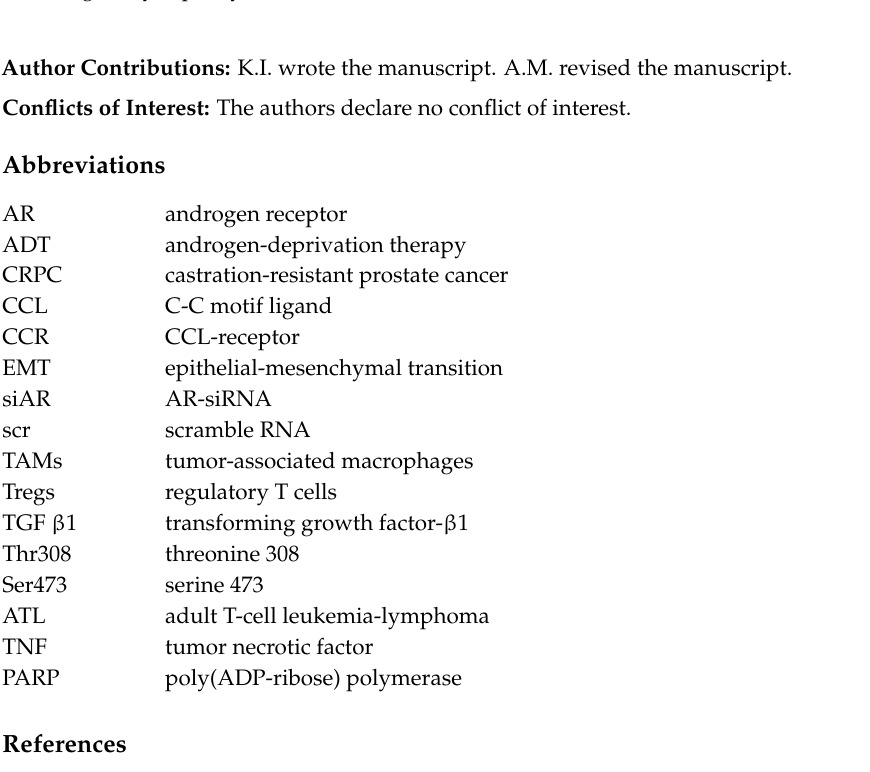
Figure 1. Androgen receptor (AR) and C-C motif ligand (CCL)-receptor (CCR) axes. (1) Androgen/AR signaling negatively regulates CCL2 secretion and inhibits prostate cancer cell migration. The CCL2-CCR2 axis contributes to chemoresistance to taxanes. (2) The CCL22-CCR4 axis is located downstream of the CCL2-CCR2 axis and increases the migratory capacity of prostate cancer cells. (3) CCL5 activity occurs upstream of AR signaling and increases the migratory capacity of prostate cancer cells via inhibition of androgen/AR signaling. (4) CCL4 is positively regulated by androgen/AR signaling in macrophages, and is a key regulator during prostate tumorigenesis. (5) TNF, which is negatively regulated by androgen/AR signaling, induces CCR7 expression in prostate cancer cells. CCR7 subsequently binds CCL21 from fibroblastic reticular cells in lymph node, resulting in increased migratory capacity.